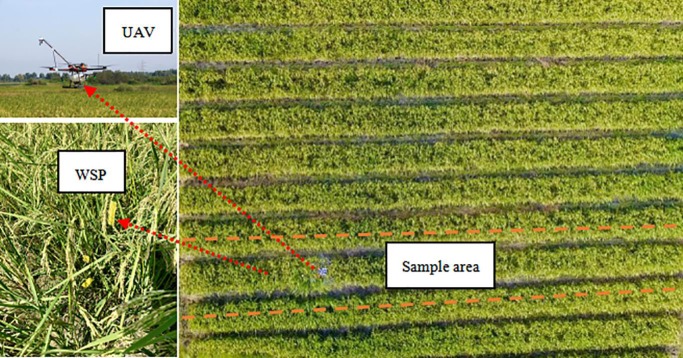
UAV and test site.